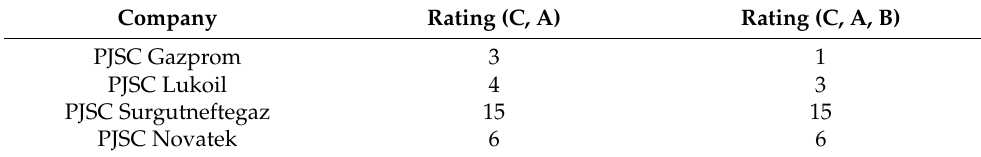
Table 3. Industry rating in the group of leaders of the 20 Russian